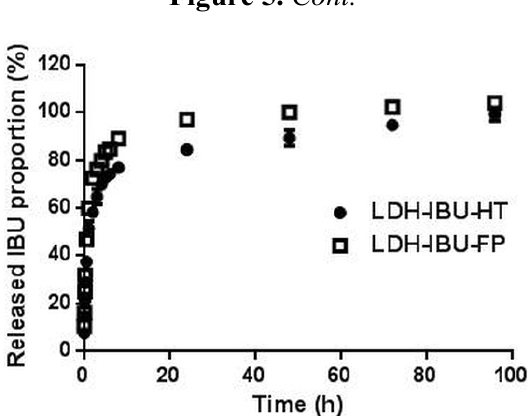
and T are the times required to release 50 90